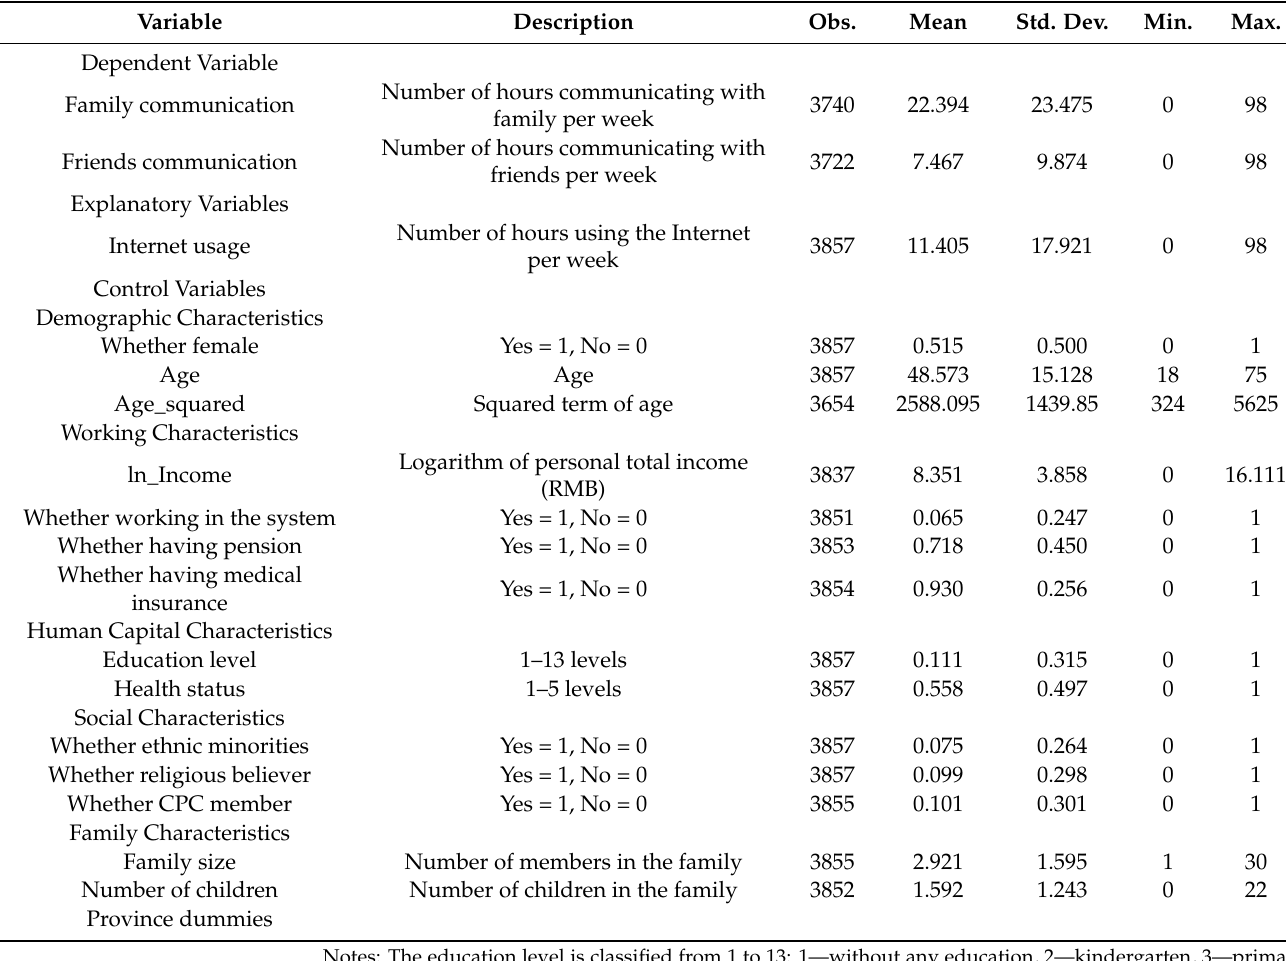
Table 1. Summary